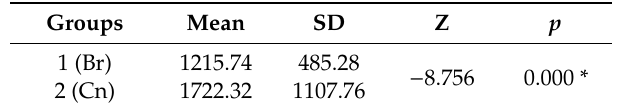
Table 4. Results for the comparison of RTs regarding the processing of grapho(-phonic)-phonologically related primed items by both